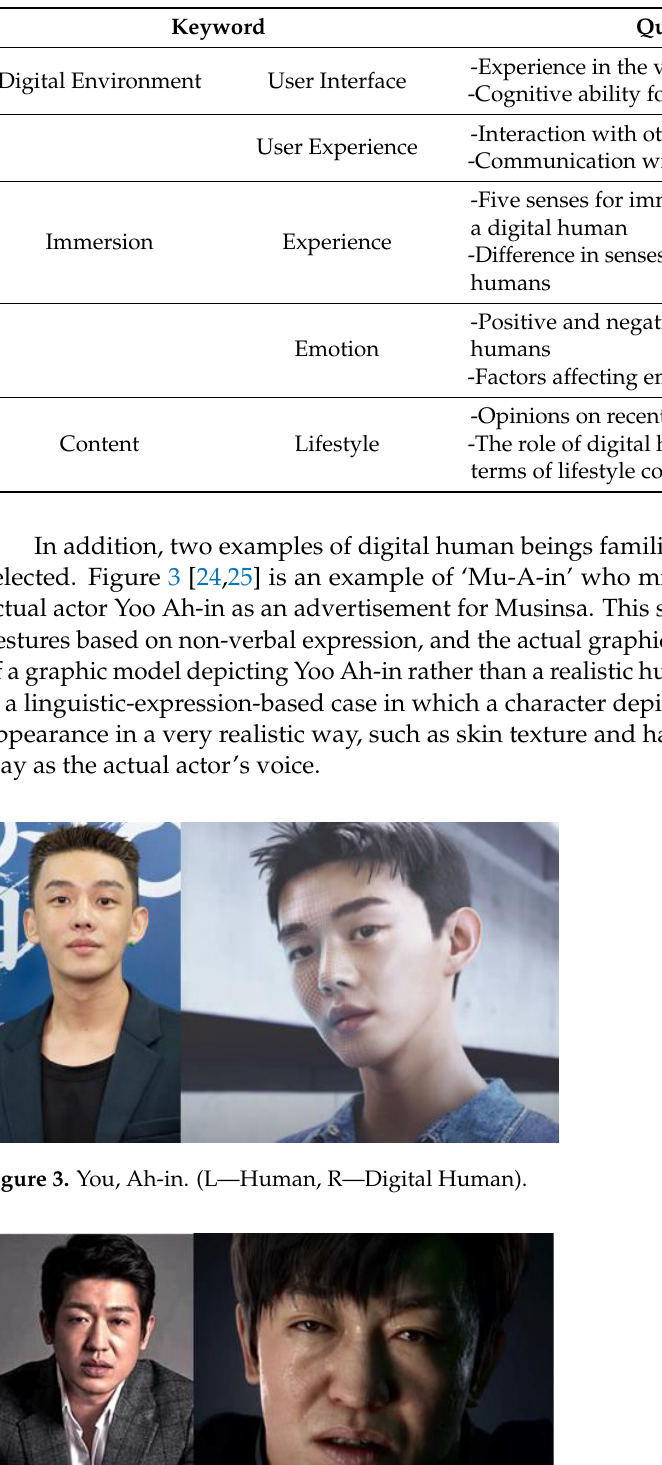
Table 7. Main questionnaire for the in-depth interview.